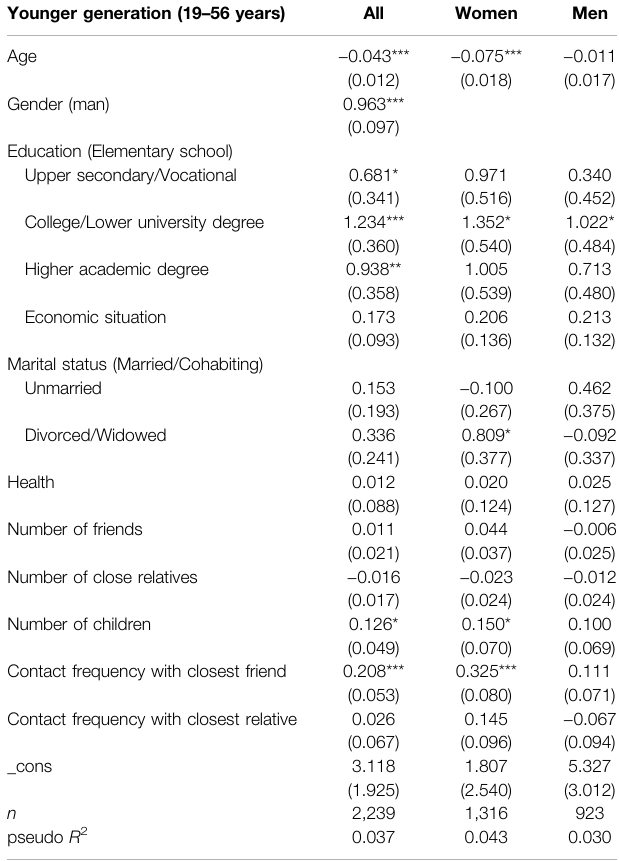
TABLE3| Predictorsofsocialmediauseinyoungandmiddle-agedFinnishadults (born 1962 – 1999) ( n (cid:1) 1945). β -coef fi cients and (standard errors). Younger generation (19 – 56